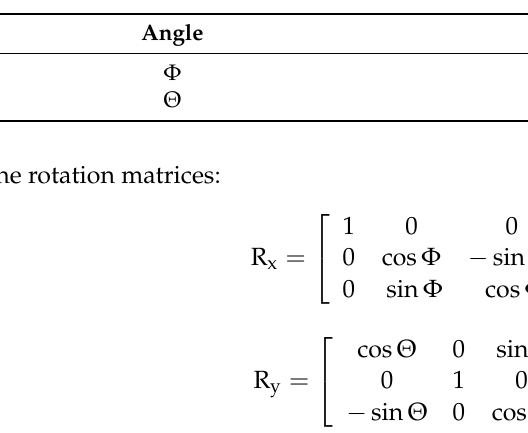
Table 4. Tilt angles of the regression lines.